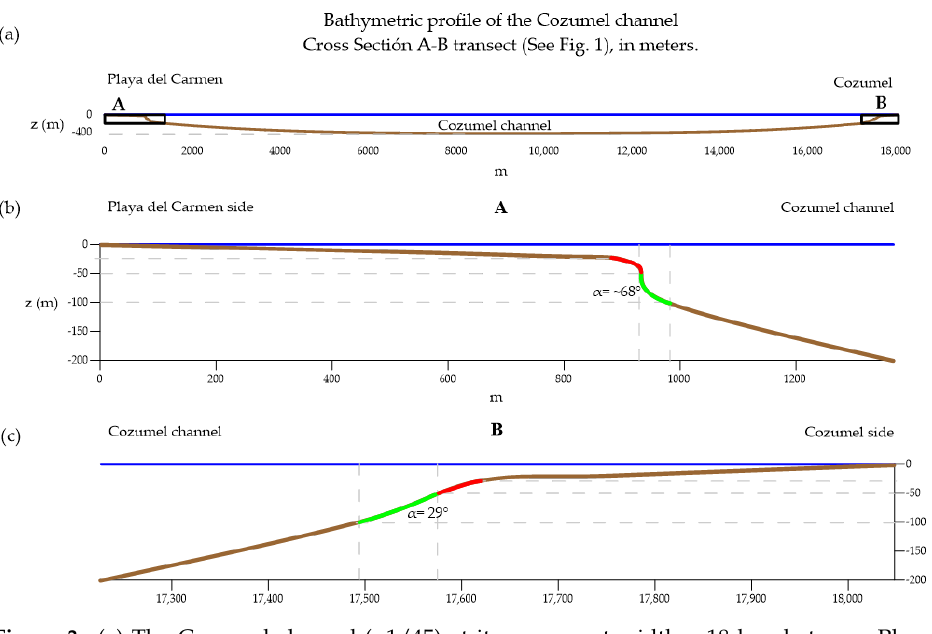
Figure 3. ( a ) The Cozumel channel (~1/45) at its narrowest width, ~18 km, between Playa del Carmen and the town of Cozumel. ( b ) The coast off Playa del Carmen; ( c ) The coast off Cozumel.